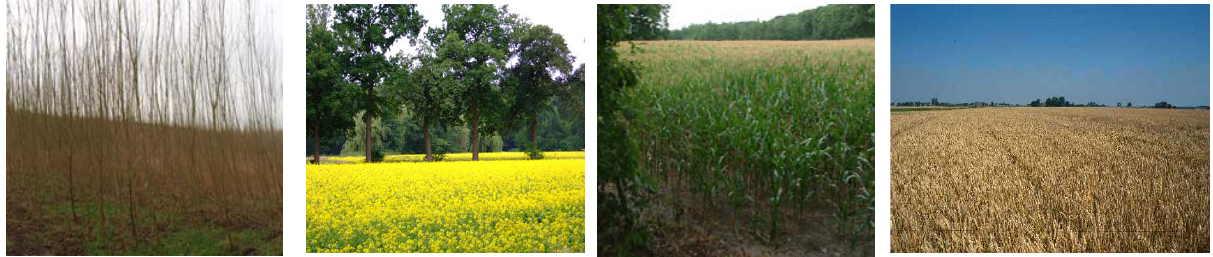
Fig 2. The uptake of heavy metals, the winning of bioenergy and the use of plants to remediate soils polluted with heavy metals will be optimized and evaluated economically for short rotation coppice, rape seed, maize and wheat